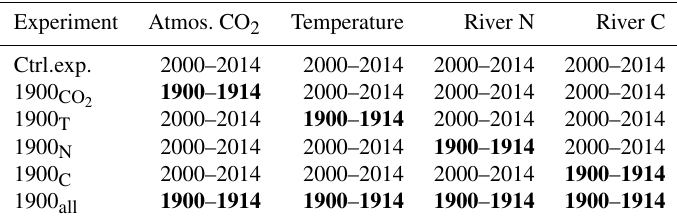
Table 1. List of experiments conducted in the study (see Methods section for their description) with their differences from the control experiment highlighted in